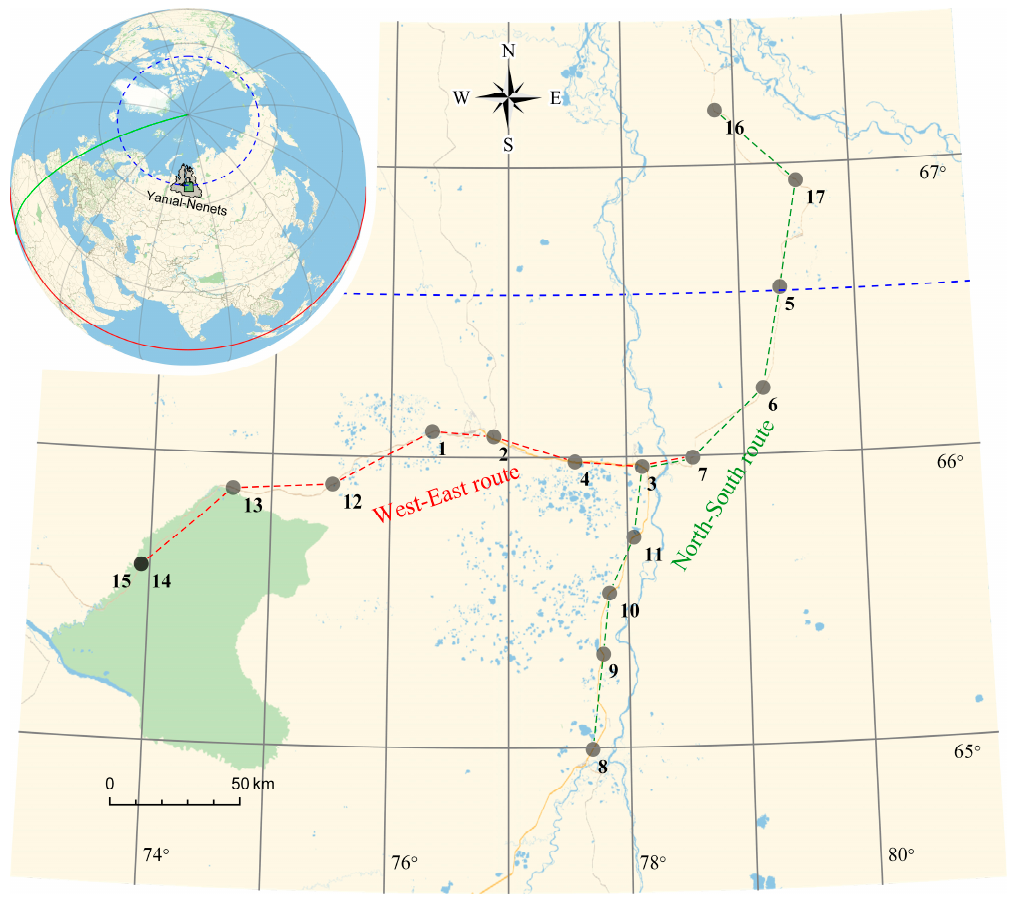
Figure 1. Map of integrated snow sampling in the Arctic part of Western Siberia. Table 1. Register of samples taken from the Arctic part of Western Siberia in